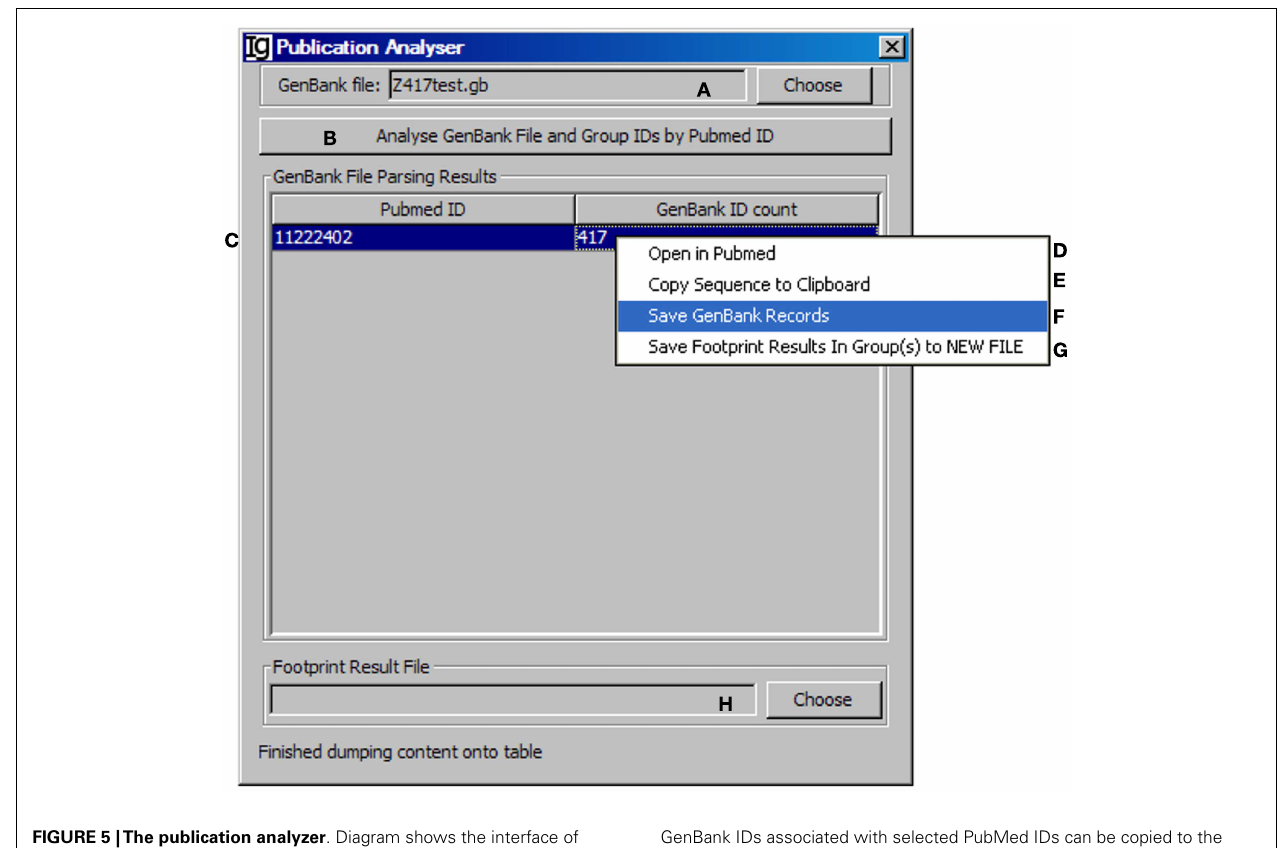
FIGURE 5 |The publication analyzer . Diagram shows the interface of the Publication Analyzer .The user can choose the input GenBank file (A) , start the publication analysis process (B) .The number of GenBank records in association with each PubMed ID will be shown in the window area (C) . By clicking on each GenBank ID, the abstract pages of selected PubMed IDs at the NCBI database can be opened (D) ; the